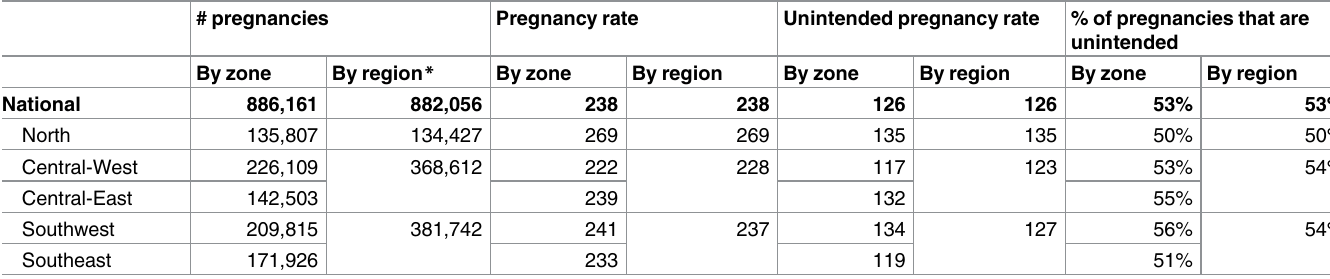
Table 5. Estimated pregnancies (overall and unintended) in Malawi, 2015.